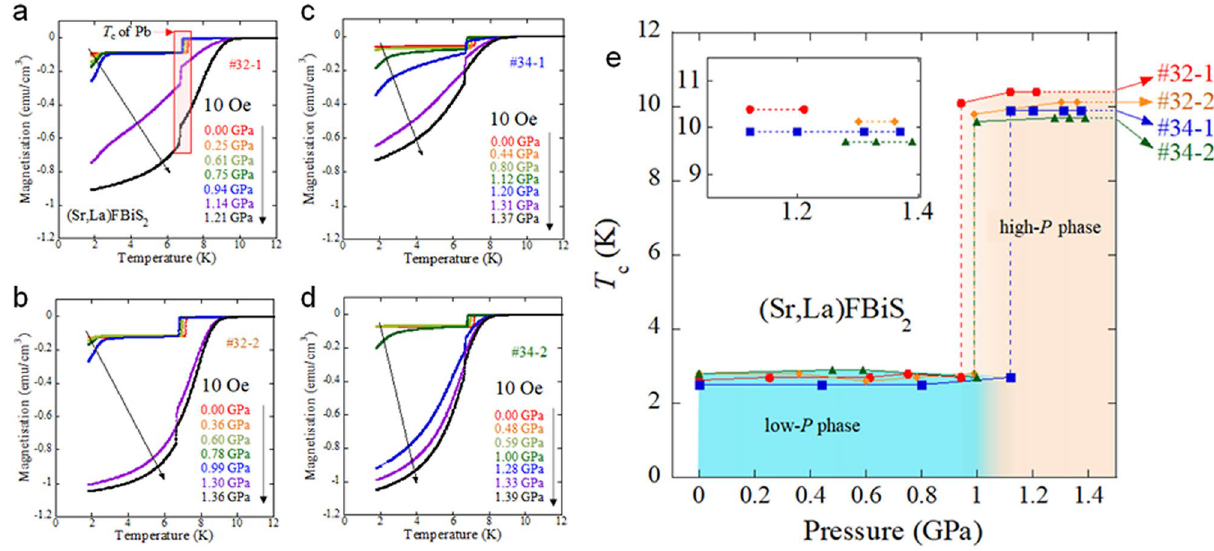
Figure 2. External pressure effects on the temperature dependence of magnetisation for isotope samples of Sr 1− x La x FBiS 2 . ( a – d ) Temperature dependences of magnetisation for 32-1, #32-2, #34-1, and #34-2, respectively. Superconducting transitions at around 7 K are T c of the Pb manometer. ( e ) Pressure dependence of T c . The inset shows the enlarged plot for the data of high- P phases. Note that the T c for low- P phases was roughly estimated because of superconducting signals mixed with those of the high- P phase and the Pb manometer. See Supplementary file for the estimation of the T c for the low- P